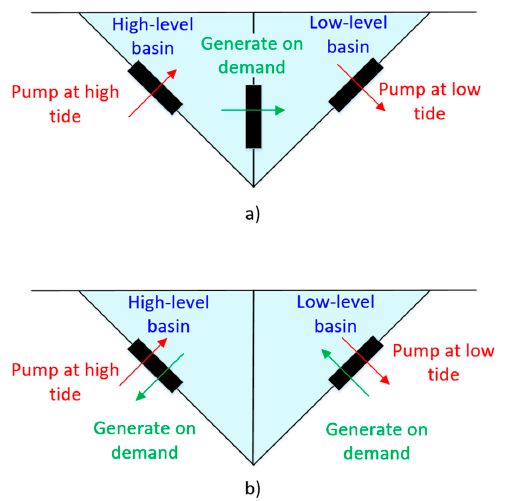
Figure 13. Two possible configurations for a two-basin tidal power generating system; ( a ) water is allowed to flow between the two basins; ( b ) water is allowed to flow only between each basin and the sea.